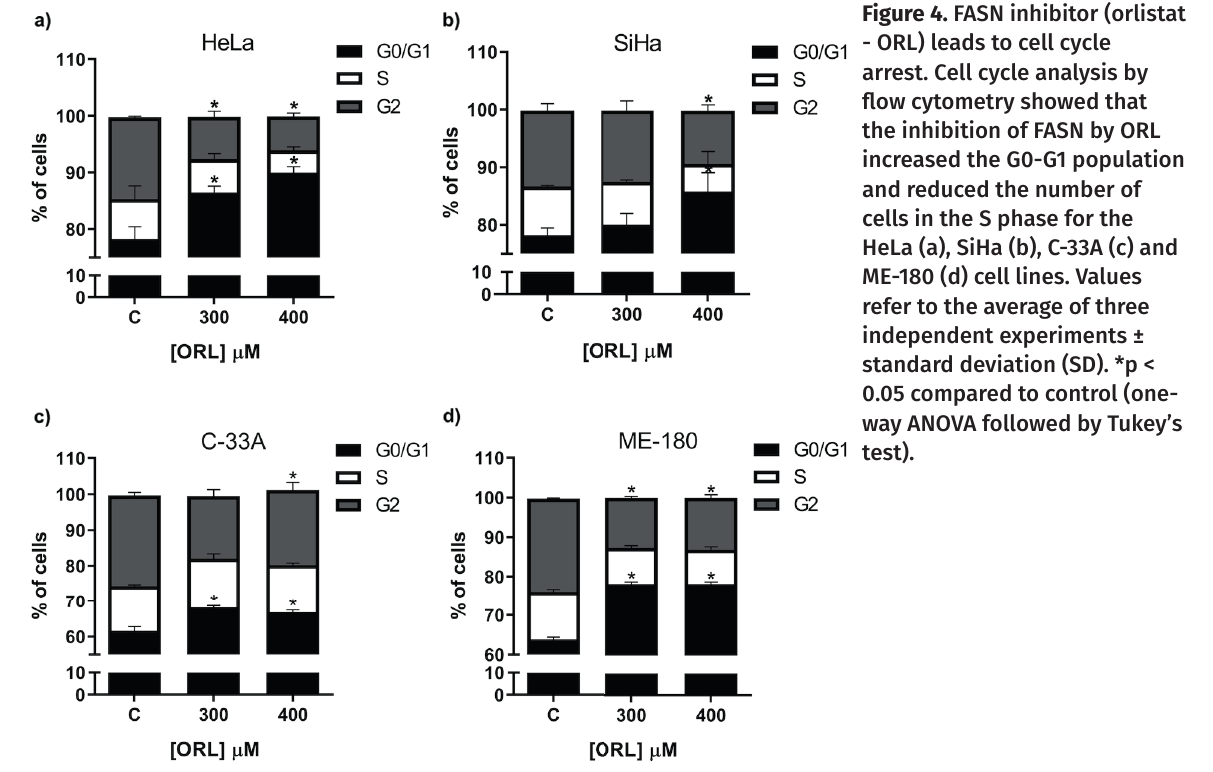
Figure 4. FASN inhibitor (orlistat - ORL) leads to cell cycle arrest. Cell cycle analysis by fl ow cytometry showed that the inhibition of FASN by ORL increased the G0-G1 population and reduced the number of cells in the S phase for the HeLa (a), SiHa (b), C-33A (c) and ME-180 (d) cell lines. Values refer to the average of three independent experiments ± standard deviation (SD). *p < 0.05 compared to control (one- way ANOVA followed by Tukey’s